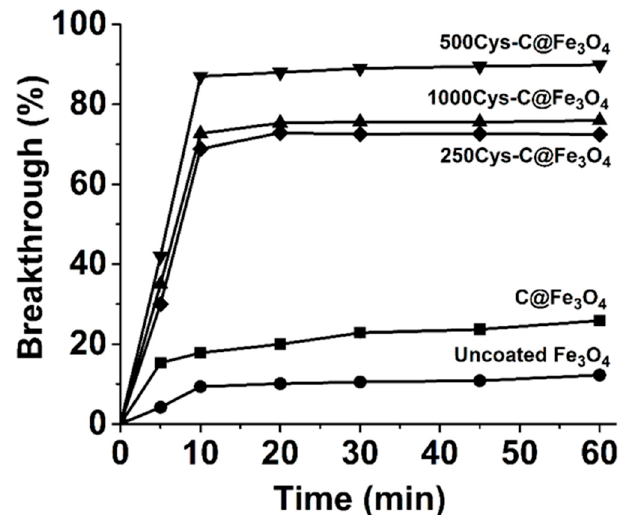
Figure 4. Hg(II) treatment time dependence of % Breakthrough (BT) at initial Hg(II) concentration of 1000 ppb and sorbent loading of 0.01 g L − 1 . High reproducibility of the measurements is indicated by small standard deviations from five identical batch